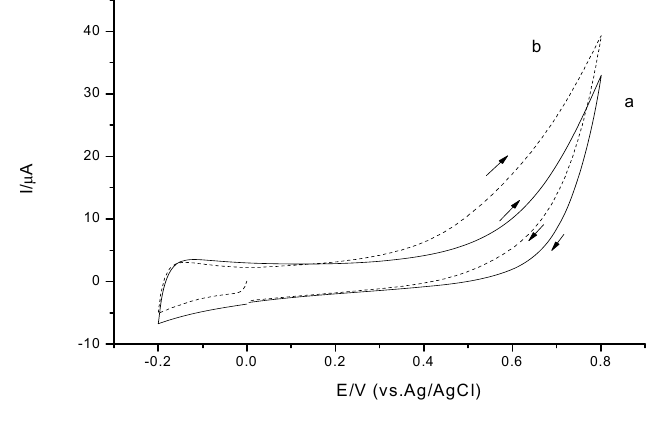
O (b). Scan rate 20 mV·s − 1 2 2